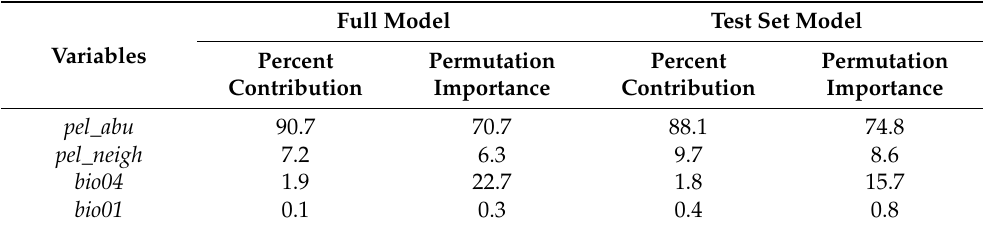
Table 1. The table shows the importance of each variable for the full MaxEnt model (including all the data) but also the mean and the standard error for the 100 interactions tested on the split dataset that included 80% of the data and 20% used as a test set: annual mean temperature ( bio01 ), temperature seasonality ( bio04 ), Pelargonium abundance ( pel_abu ), neighbouring Pelargonium abundance ( pel_neigh ). Full Model Test Set Model Variables Percent Permutation Contribution